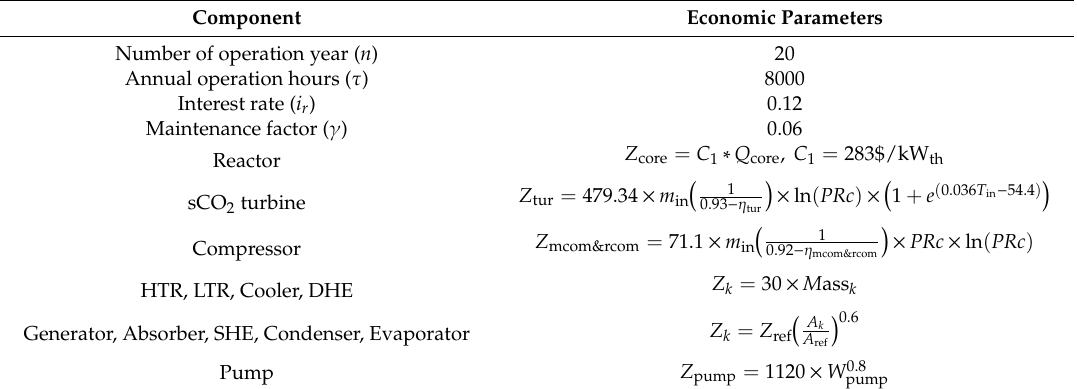
Table 3. Cost functions of the system components [11,32,34].